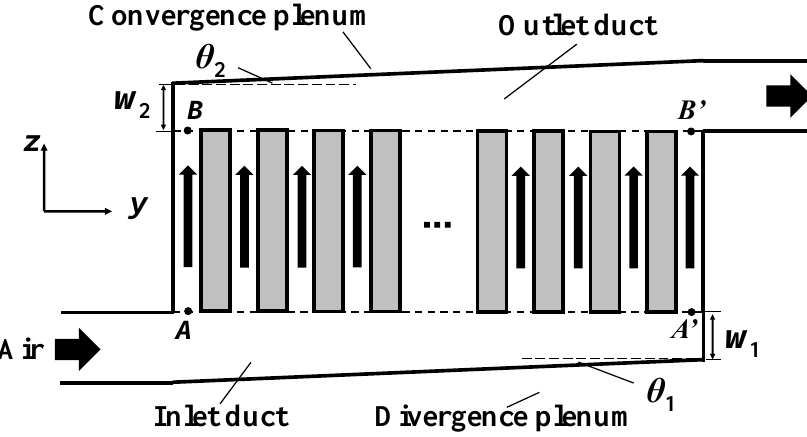
Figure 11. Schematic of the characteristic points in the air-cooled